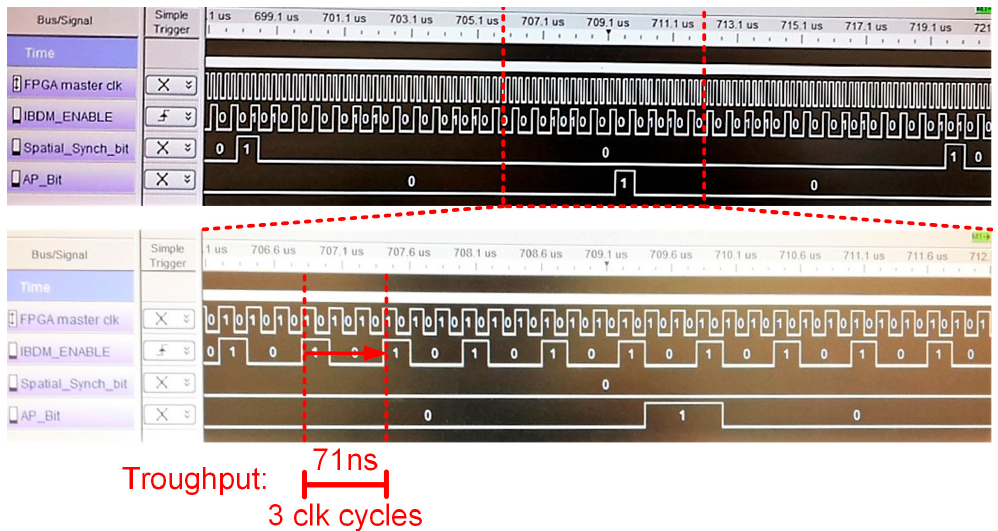
Figure 13. Pipelined action potential detector output bits.